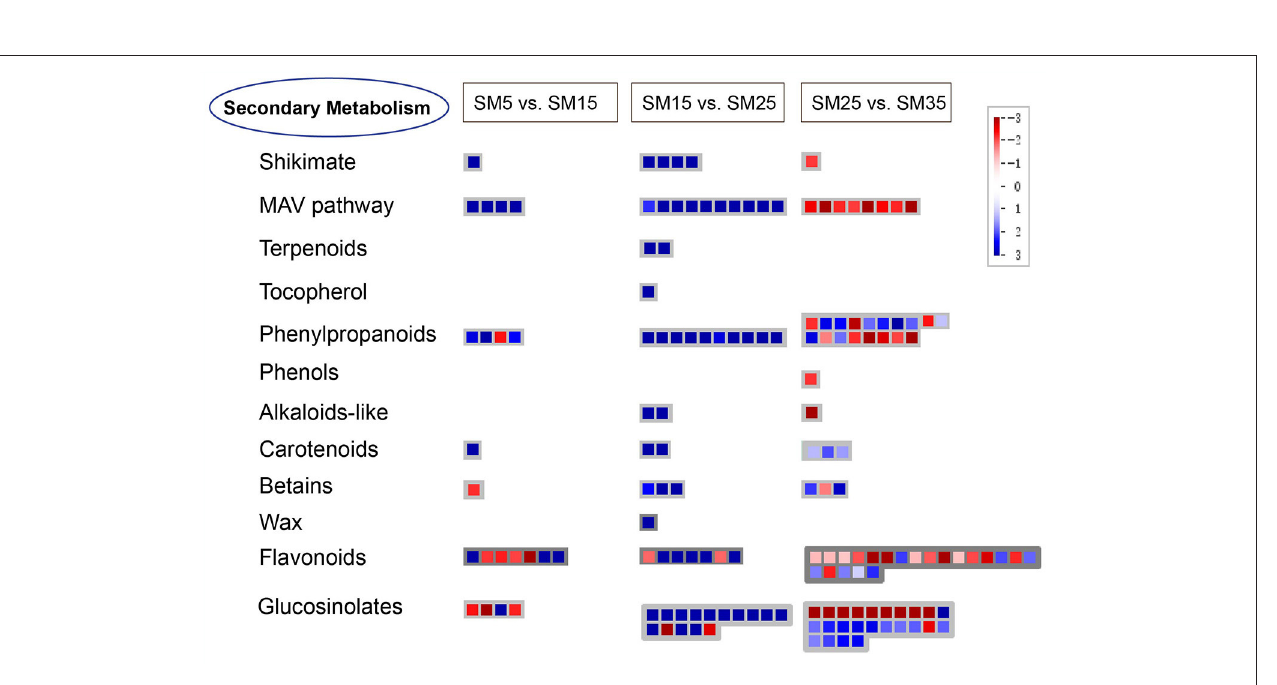
FIGURE 10 | Schematic diagram of the transcriptional changes of genes involved in secondary metabolism in leaves of Chinese fir at different stand ages. The log 2 FC of DEGs in SM15, SM25, and SM35 compared with SM5, SM15, and SM35 is presented using the MapMan visualization platform. SM5, SM15, SM25, and SM35 represent stand ages of 5, 15, 25, and 35 years,